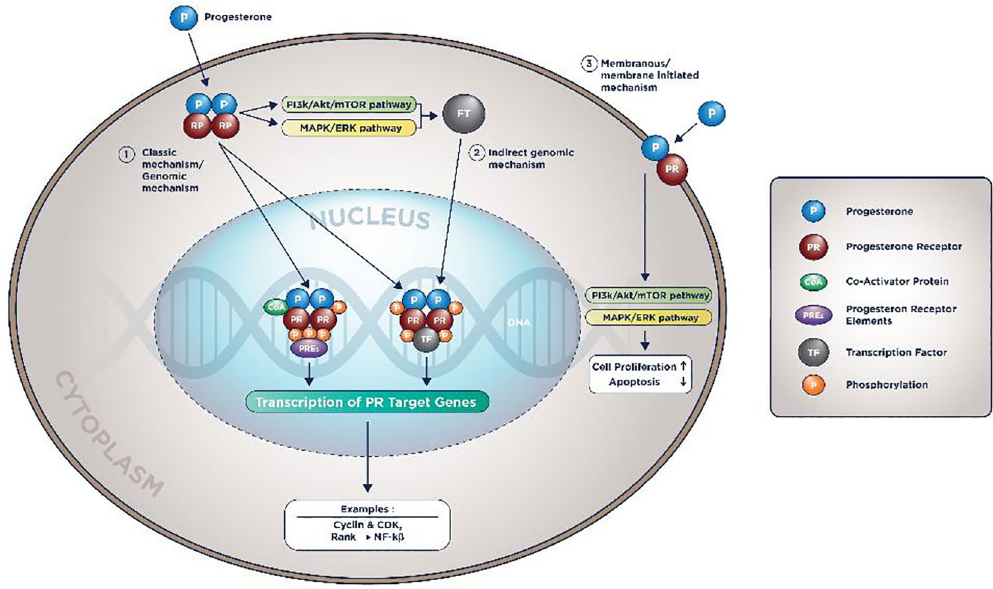
Figure 2. PR molecular mechanism of